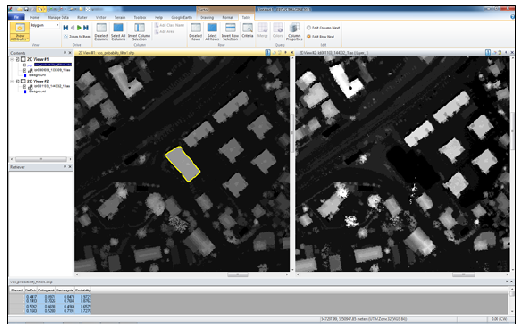
Figure 5. This polygon is a correct detection.